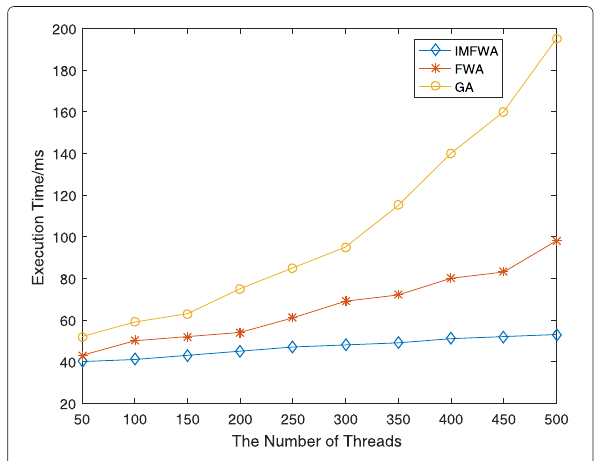
Fig. 3 Execution results of the three algorithms